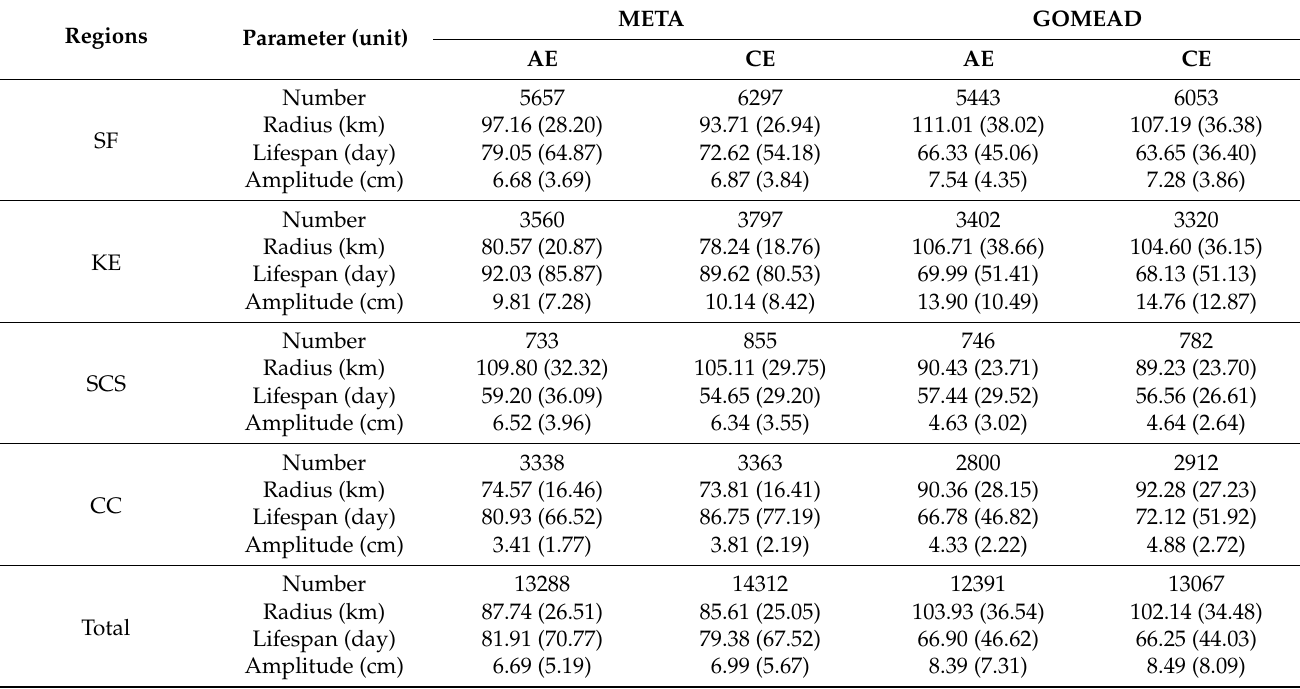
values (standard deviations) are shown outside (inside) the